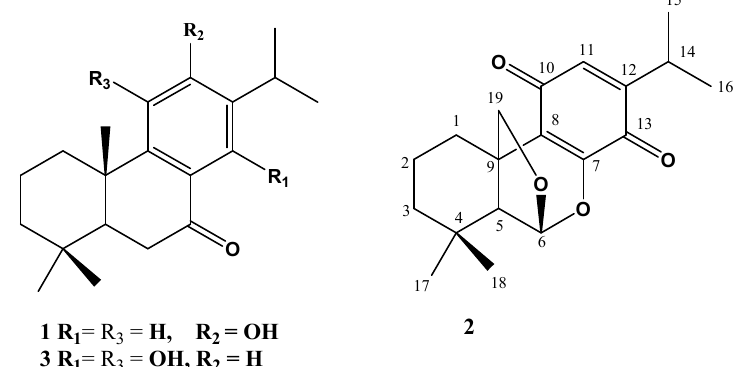
Figure 1. Chemical structure of compounds 1–3 .